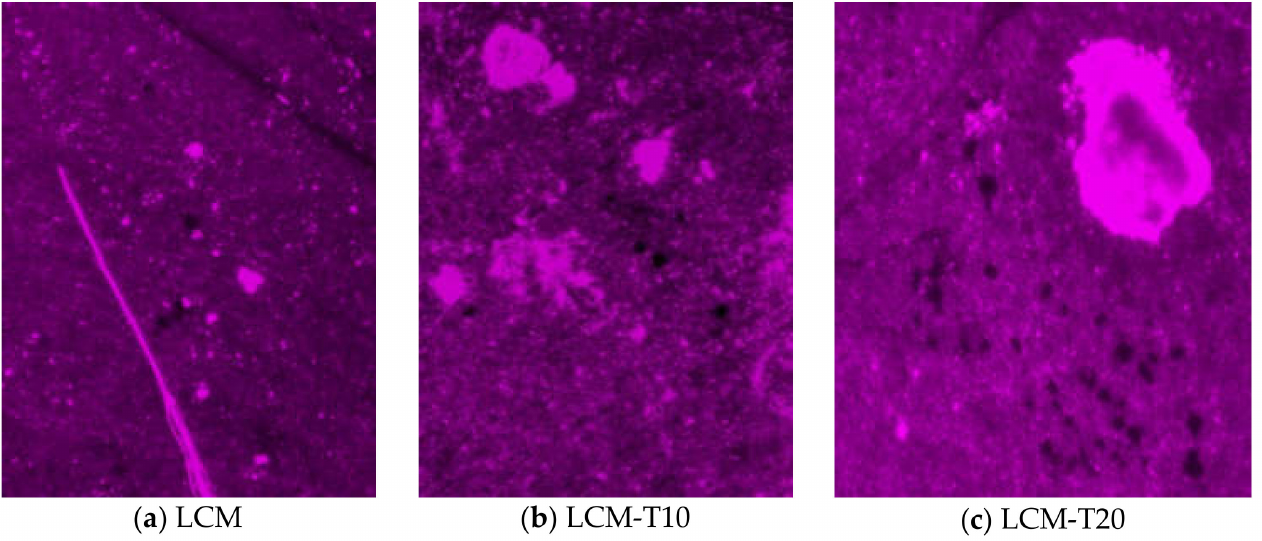
Figure 1. Images of the interaction points of the sperm with the vitelline membrane on the 15th day after insemination (a fragment of the visual field) depending on the cryopreservation medium used (LCM, LCM-T10, and LCM-T20